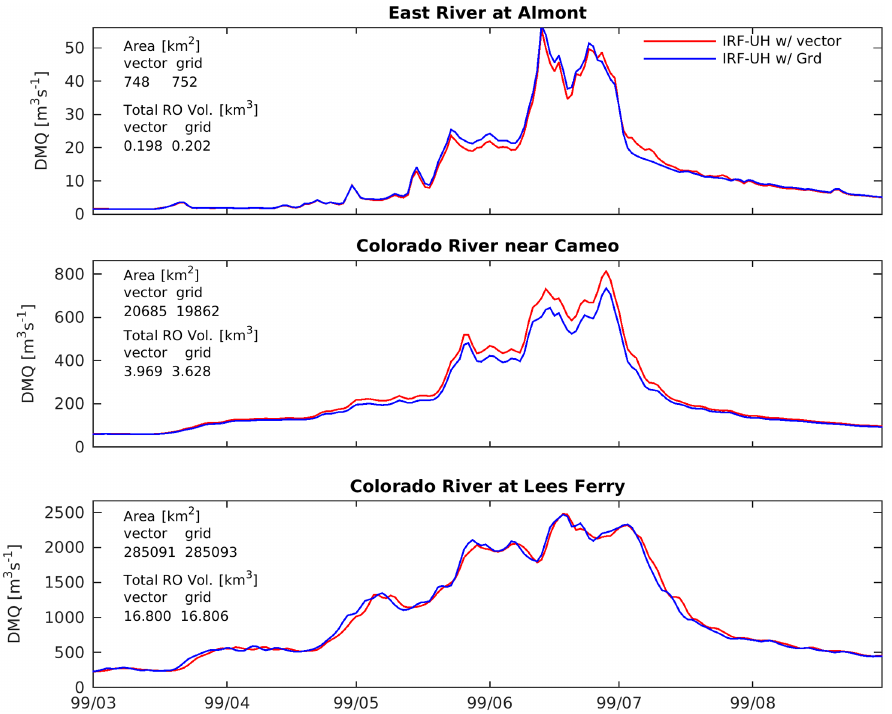
Figure 11. Comparison of IRF-UH routed flow with two river networks (1 / 8 ◦ grid-based river network and GF vector-based river network) at three locations in the upper Colorado River basin (See Fig. 10 for river network and basin